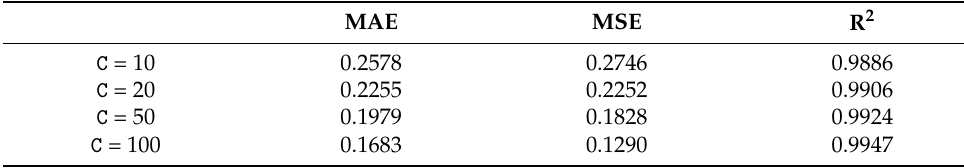
Table 2. The errors of SVR.